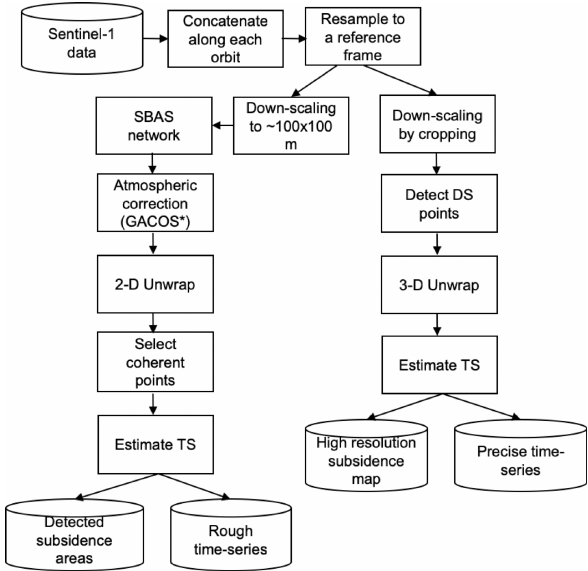
Figure 2. Flowchart of our multi-scale approach to detect and monitor land subsidence using large stacks of Sentinel-1